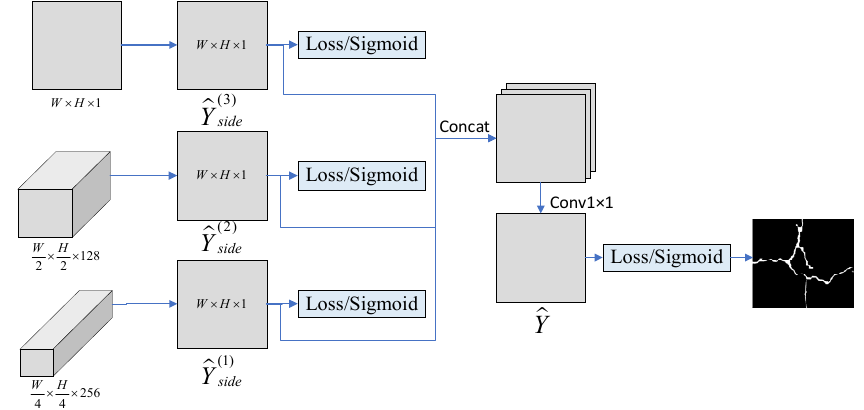
Figure 7. Multi ‐ loss function design. Figure 7. Multi-loss function